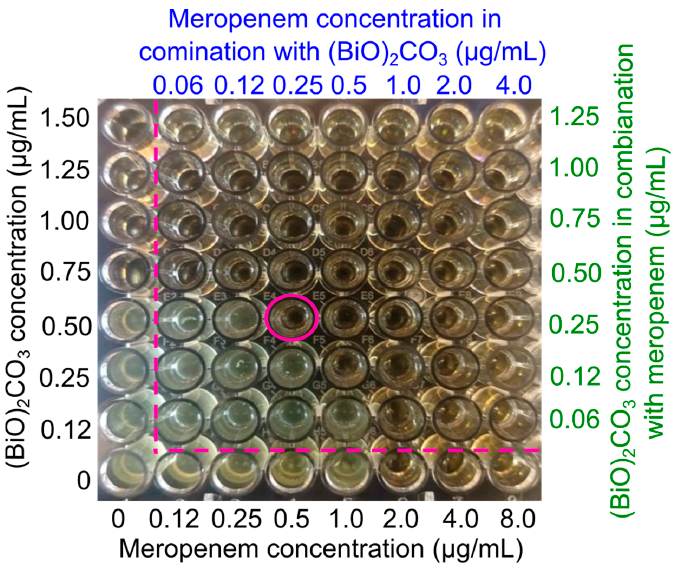
Figure 4. Checkerboard assay for (BiO) 2 CO 3 NPs with meropenem against DSPA.